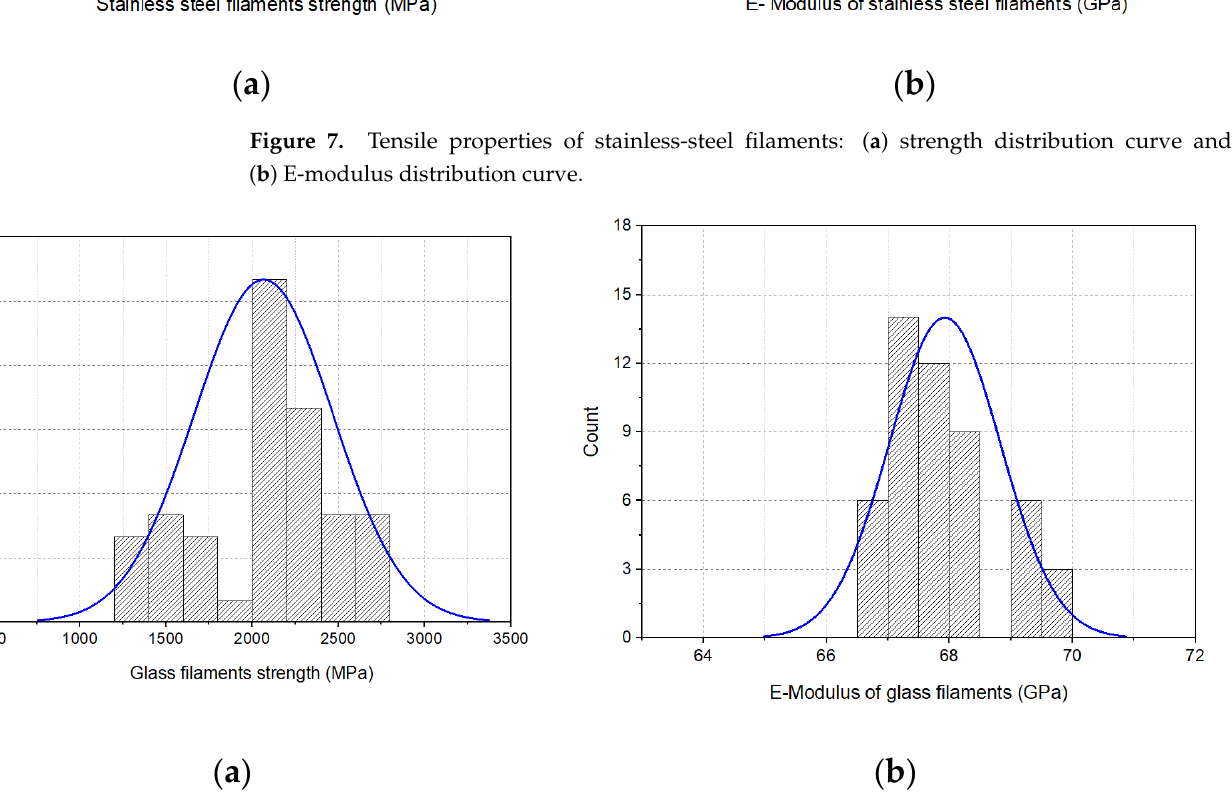
Figure 8. Tensile properties of glass filaments: ( a ) strength distribution curve and ( b ) E-modulus distribution curve.